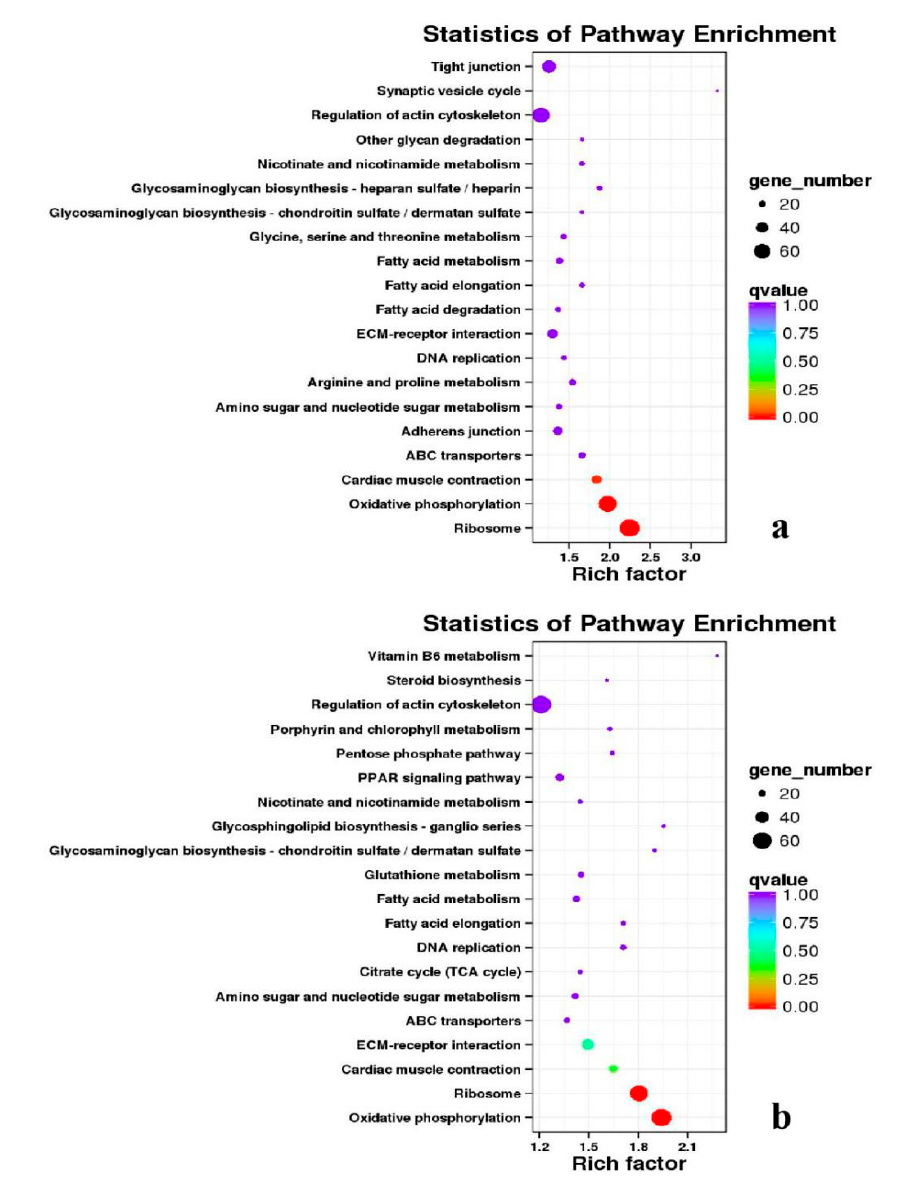
Figure 16. KEGG annotation of DEGs in leg muscle. ( a ) BE17L_vs_BE31L; ( b ) BE17L_vs_BE34L.